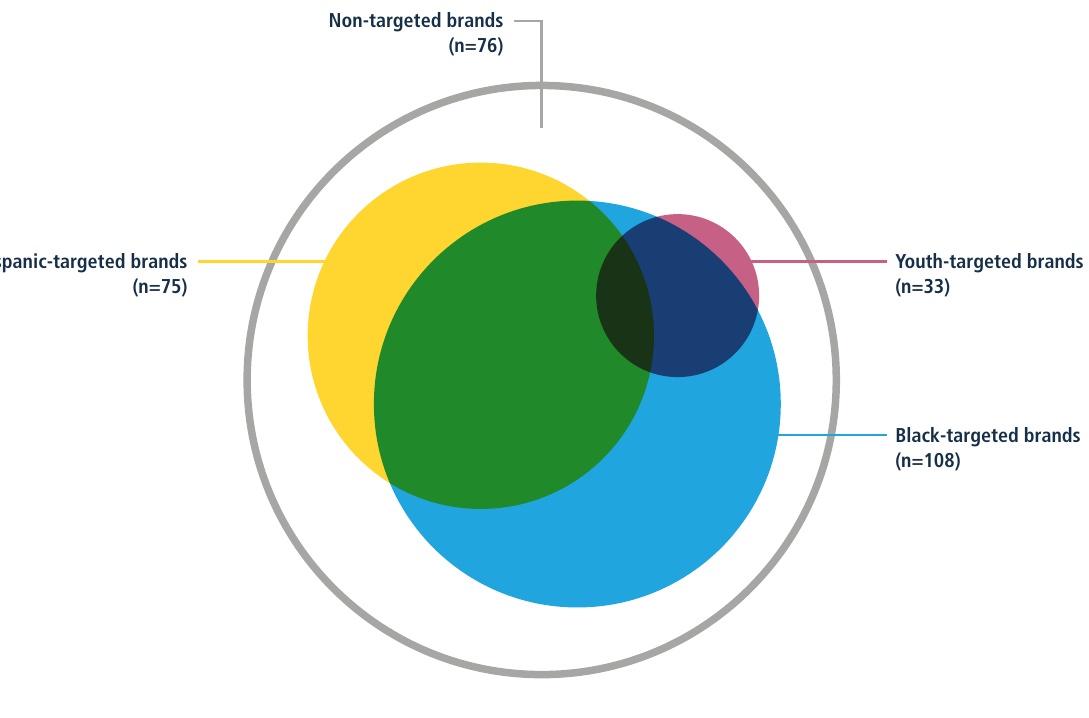
Total highly advertised brands: